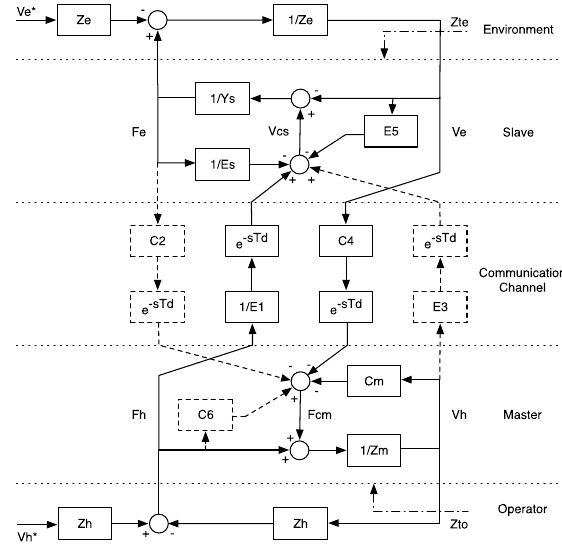
Figure 7. Block diagram of an impedance-admittance four-channel teleoperation system. In dashed lines, the non-used channels in the position-force (P-F) type control